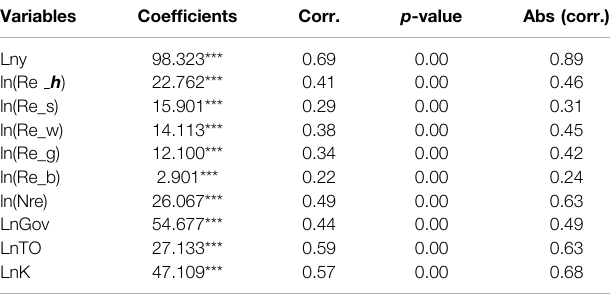
TABLE 1 | Cross-sectional dependence analysis. Variables Coef fi cients Corr.